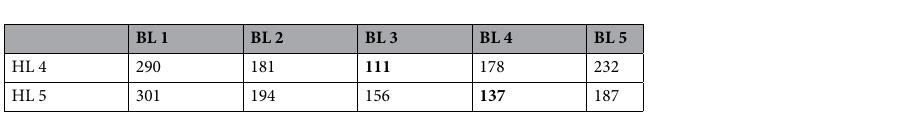
Table 1. Sum of absolute differences between the curvature histograms of the five body lines (BL) and Hogarth’s lines (HL) 4 and 5, respectively. The bold values indicate the smallest